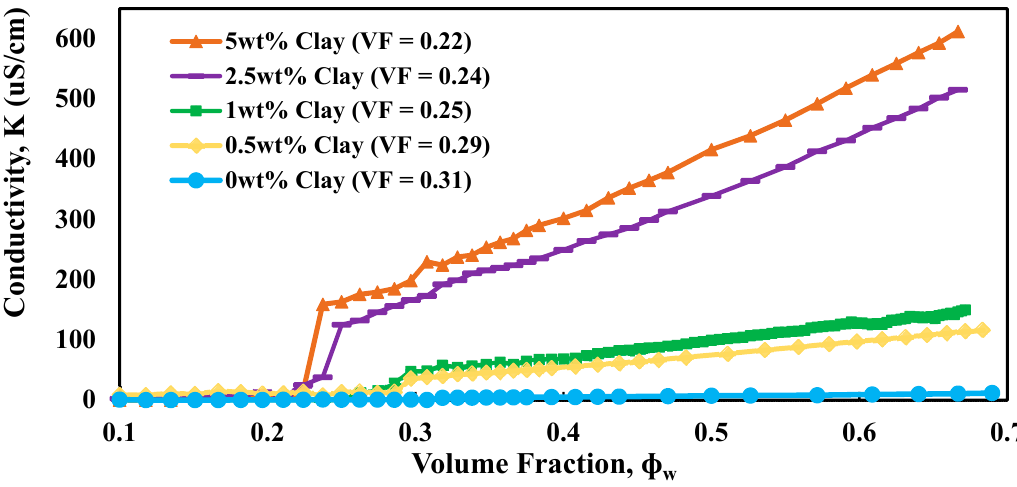
Figure 9. Conductivity of water–mineral oil emulsions stabilized by nanoclay solutions (0, 0.25, 0.5, 1, 1.75, 2.5, and 5 wt%) as a function of the volume fraction of water. Note: VF = volume fraction of water where phase inversion is observed.